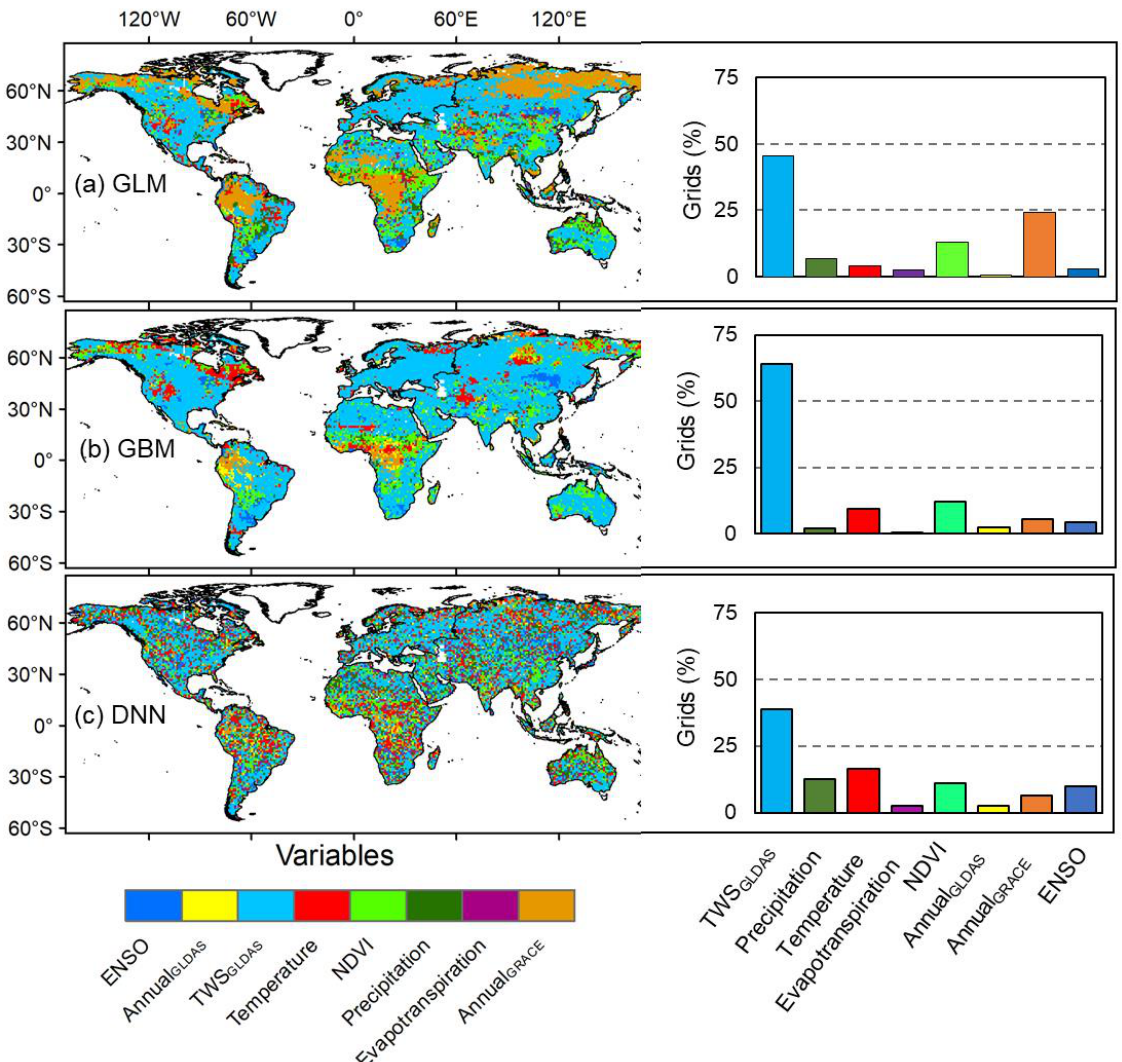
Figure 5. Spatial ( left ) and frequency ( right ) distribution of the grid-scale variable importance for ( a ) GLMs, ( b ) GBM models, and ( c ) DNN